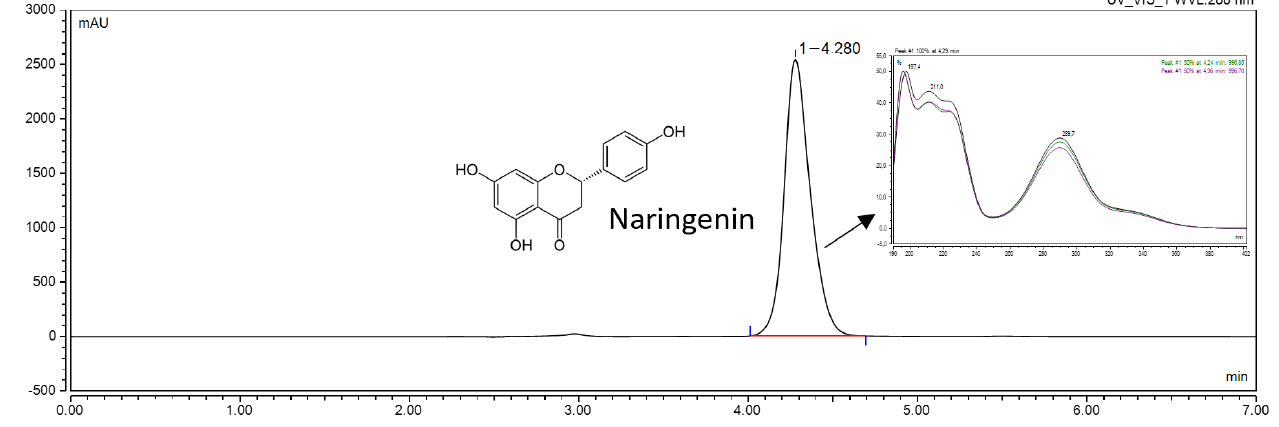
Figure 10. The chromatogram of